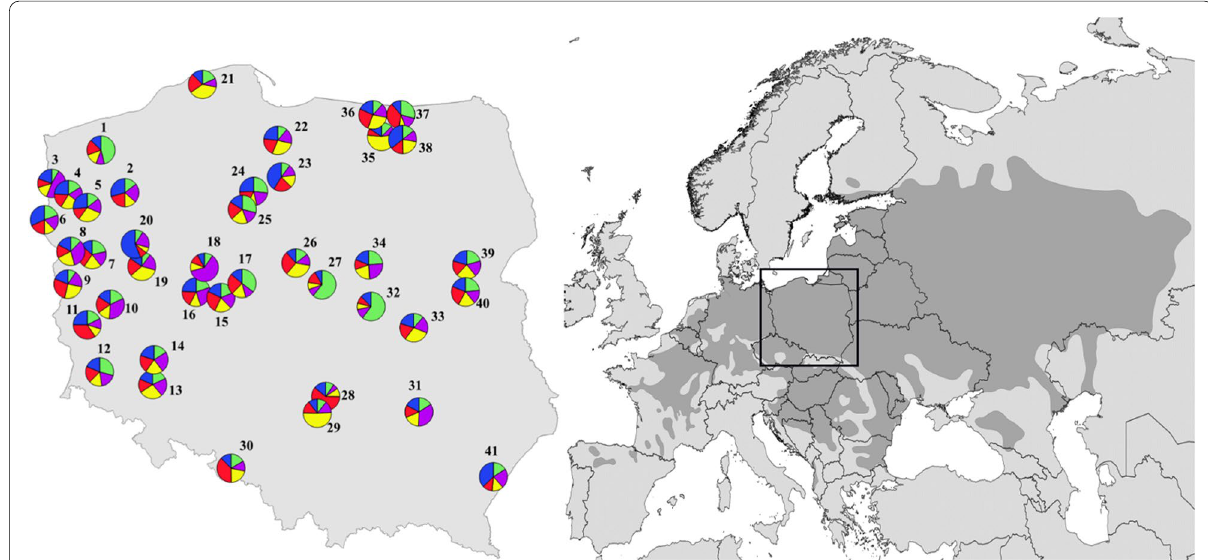
Fig. 1 Map of the current natural range of U. laevis in Europe (based on the European Forest Genetic Resources programme (EUFORGEN), www. eufor gen. org) and the locations of the 41 Polish populations included in this study. The codes representing the populations are listed in Table 1. The proportion of the membership coefficient of each individual in 41 U. laevis populations are shown for the inferred number of clusters of 5 ( K determined from the STRU CTU RE